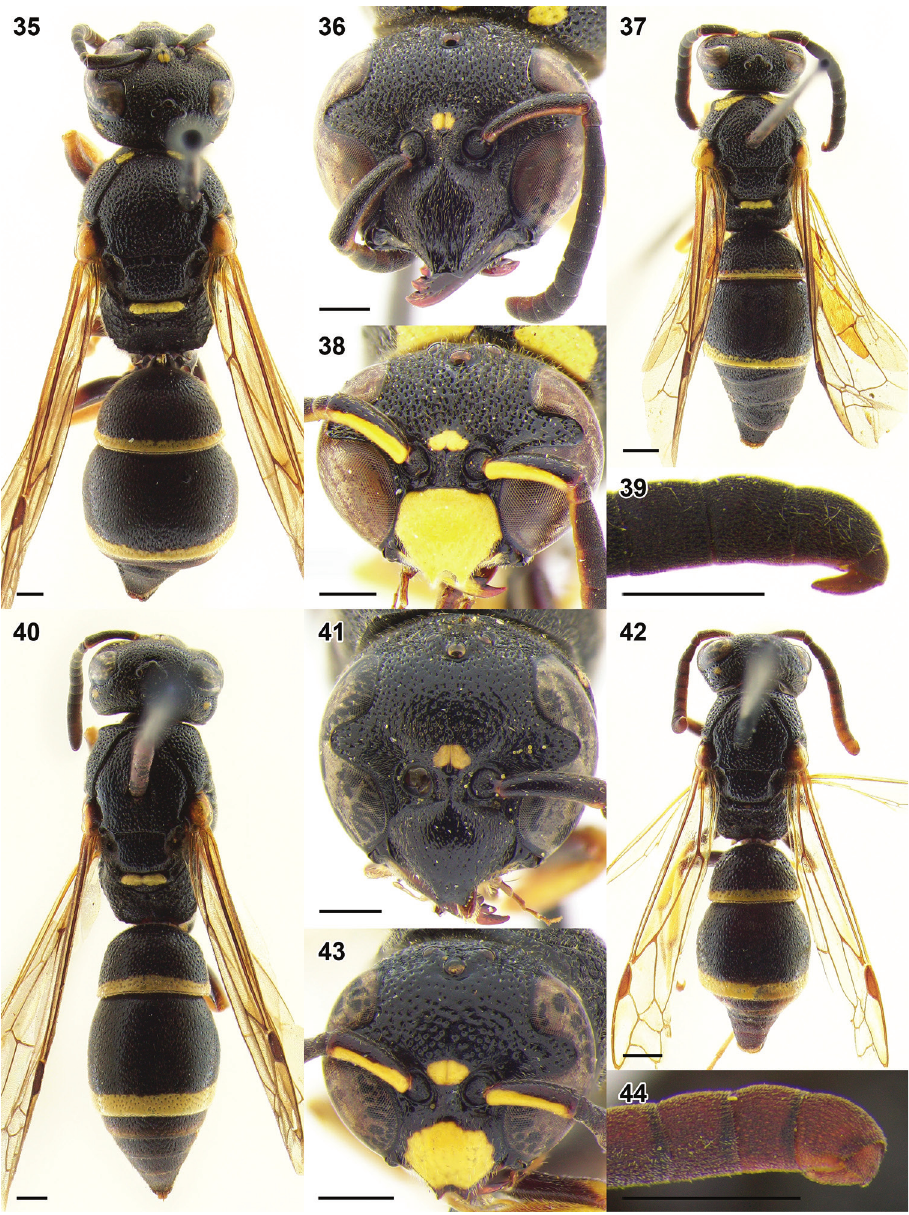
Figures 35–44. Stenodynerus punctifrons (Thomson, 1874), female, Russia (Amurskaya Prov.) ( 35, 36 ), S. punctifrons , male, Russia (Amurskaya Prov.) ( 37–39 ), S. picticrus (Thomson, 1874), female, Russia (Krasnoyarsk Terr.) ( 40, 41 ), and S. picticrus , male, Russia (Amurskaya Prov.) ( 42–44 ) 35, 37, 40, 42 dor- sal habitus 36, 38, 41, 43 head in frontal view 39, 44 apex of antenna. Scale bars 0.5